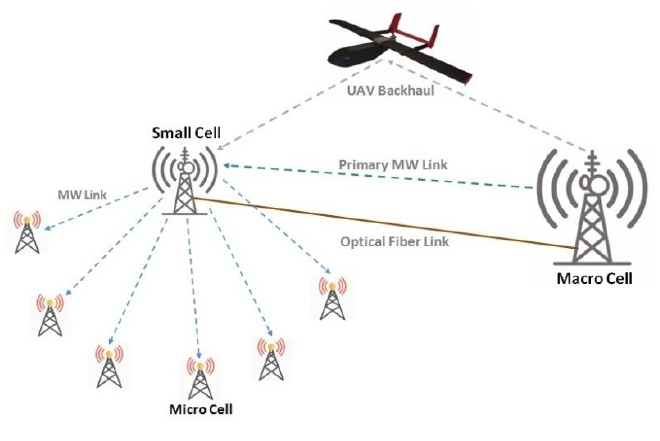
Fig 9. UAV backhaul link UAV Assisted Coverage Extension